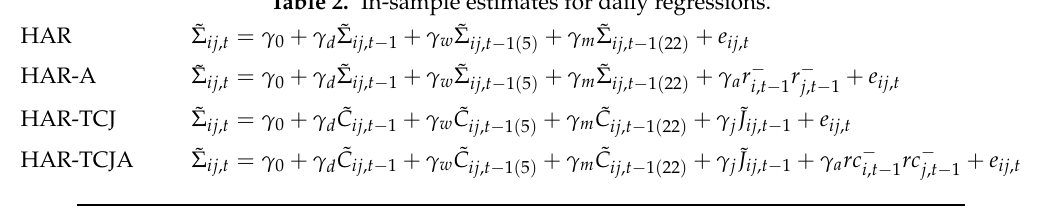
Table 2. In-sample estimates for daily regressions.